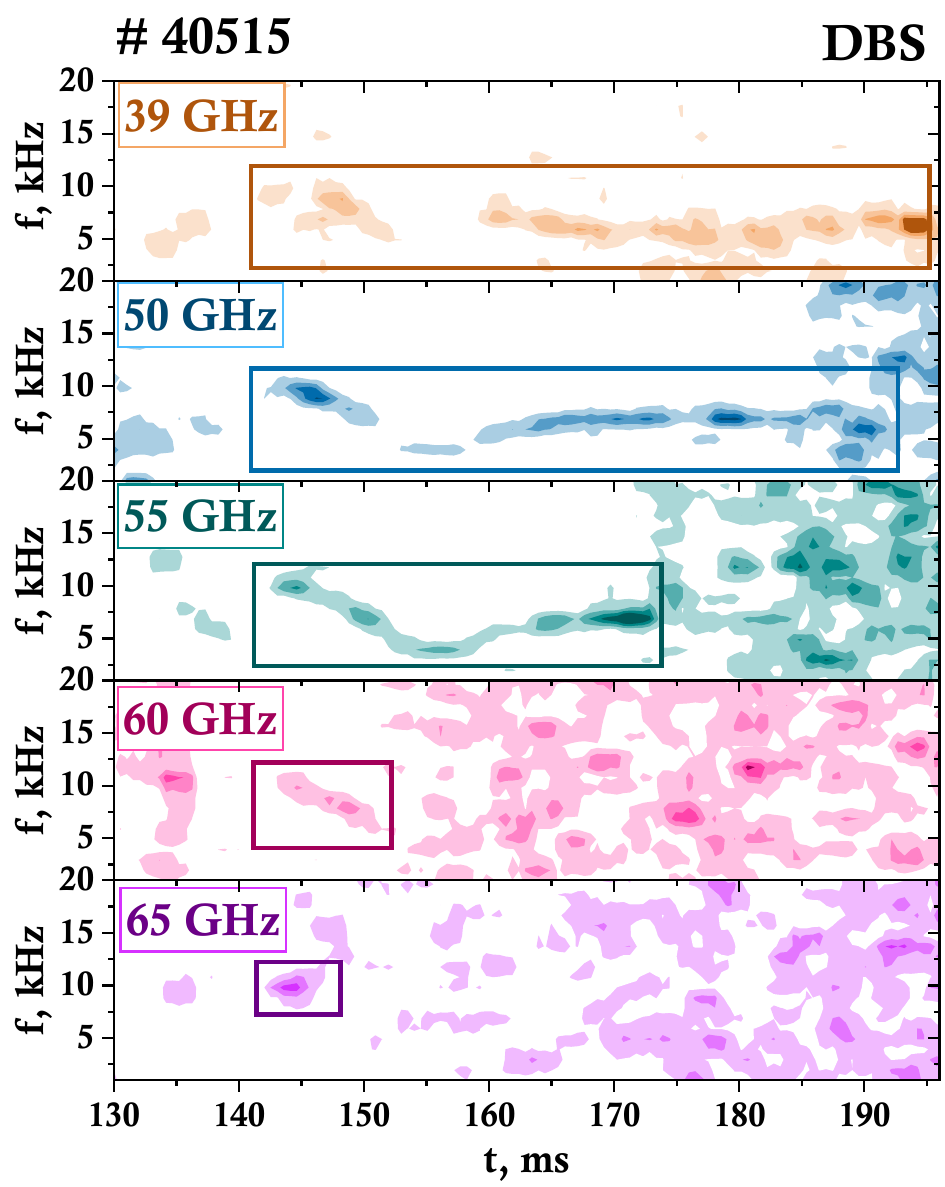
Figure 6. Spectrograms of the DBS phase derivative for discharge #40515. As the TM was found on several DBS channels, it has been dubbed the wide tearing mode. We may assume that the island width is limited by the cut-off positions of the 65 and 39 GHz frequencies. Using the cut-off radii values we can estimate the island width to be 8–10